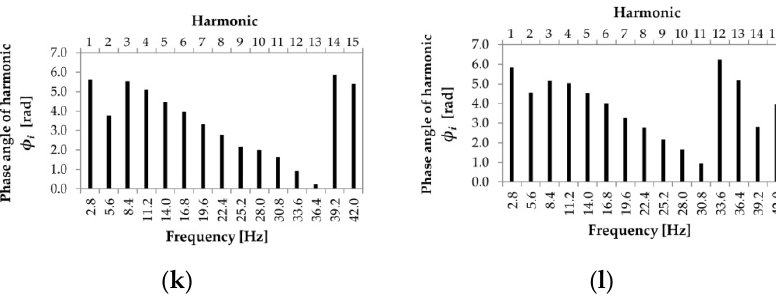
Figure 5. Sample charts of the F VGRF curves generated by heel-strike runners ( f r = 2.80 Hz) and their corresponding amplitudes and phase angles for 15 harmonics: ( a , b , g , h ) examples of the F VGRF curves; ( c , d , i , j ) normalised amplitudes of the F VGRF harmonics; ( e , f , k , l ) phase angles of the F VGRF harmonics (The data presented can be found in Supplementary Materials in the form of text files containing numerical data. See section Supplementary Materials).